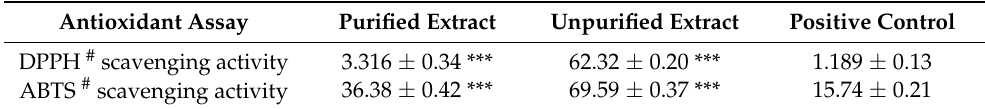
Table 1. In vitro antioxidant activities in DPPH and ABTS assays of quince purified and unpurified